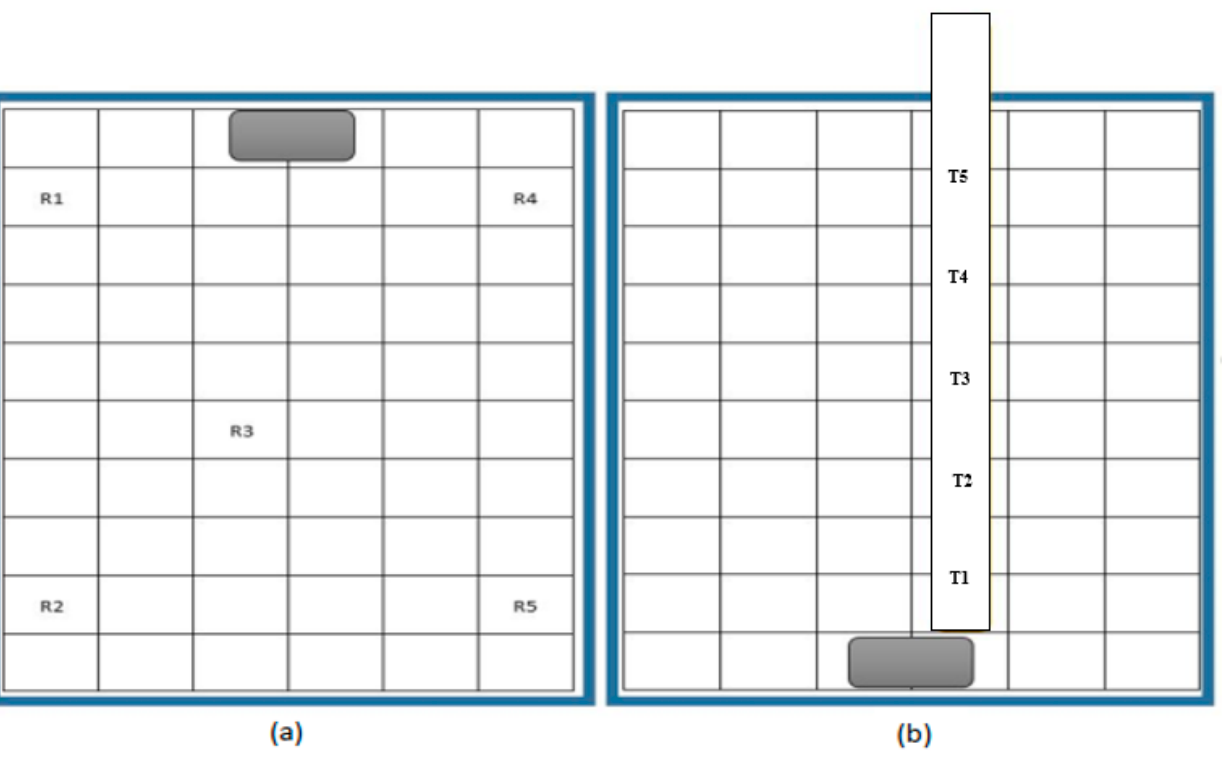
Figure 2. The distribution of the thermocouples that were used to measure the temperature of the cooled and reference PV panels. ( a ) Reference panel without heat pipe ( b ) panel with heat pipe. Table 2. The specification of the WF.